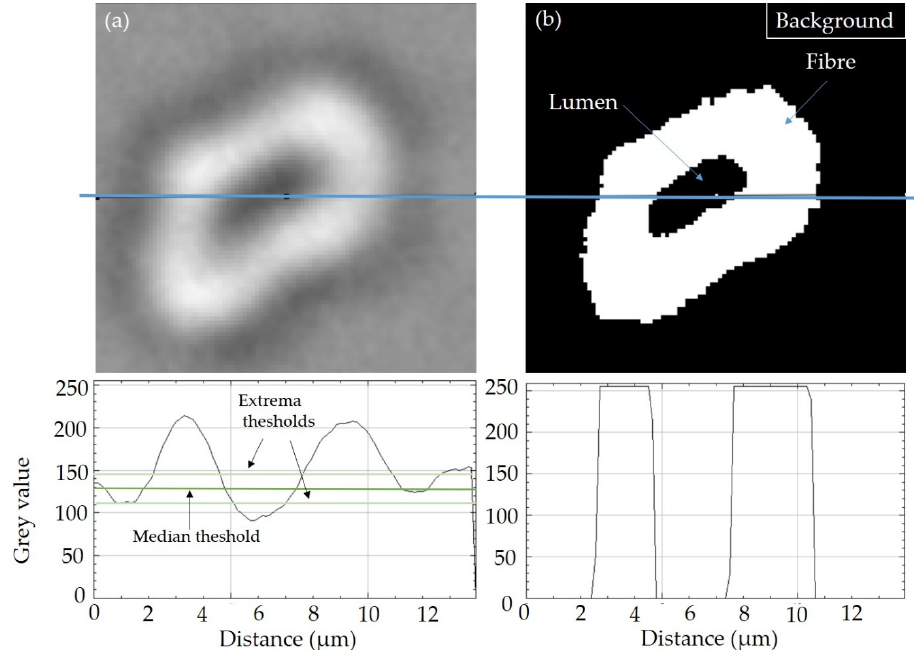
Figure 4. Example of X-ray tomography image processing, from ( a ) a greyscale cross-section of fibre “a” to ( b ) a binary image and related grey-scale level along the line (bottom) .